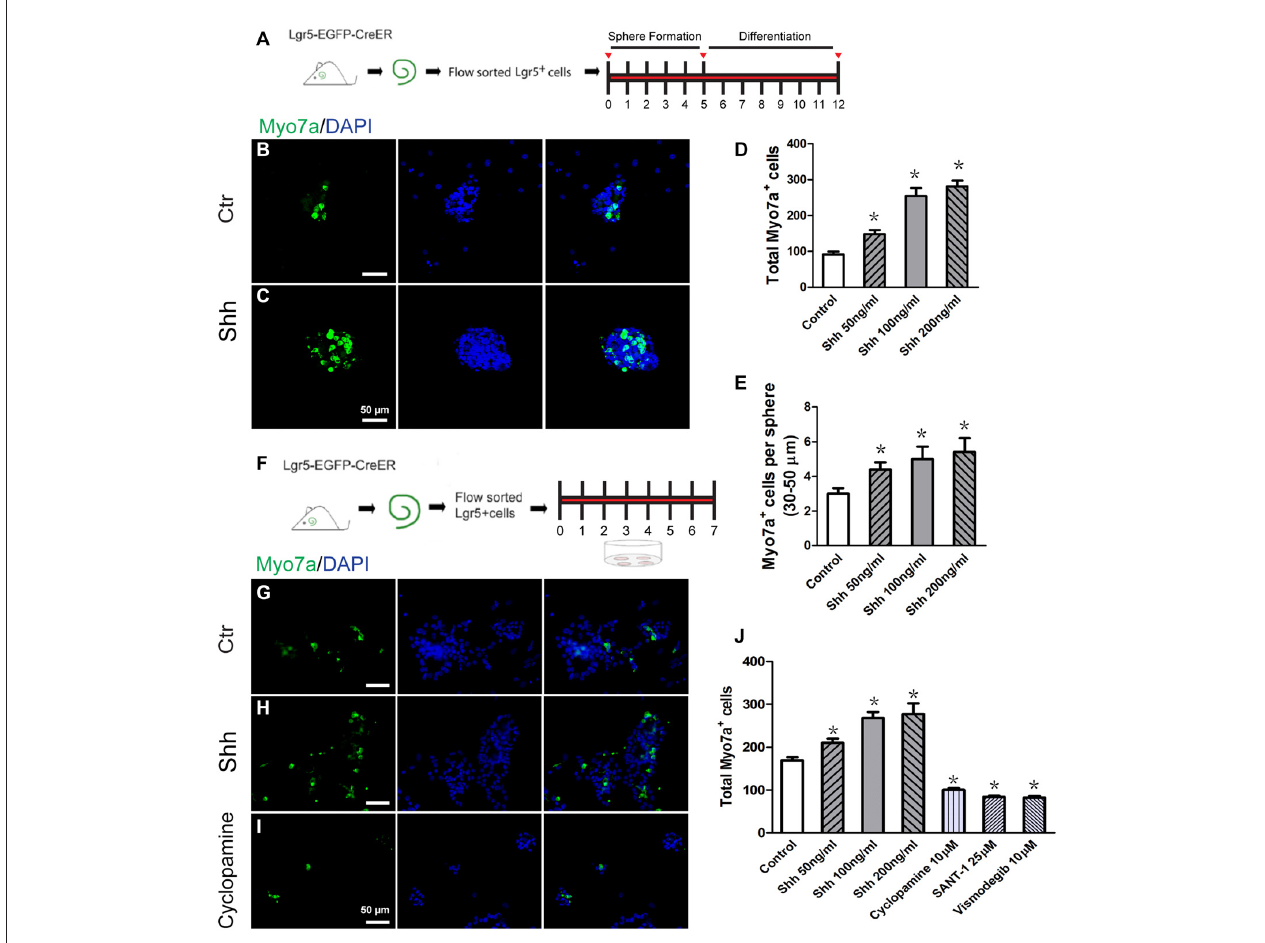
FIGURE 2 | Hedgehog signaling enhanced the hair cell (HC) differentiation of inner ear progenitor cells in vitro . (A) Diagram of the differentiation assay in Lgr5+ cell spheres. After allowing spheres to form for 5 days, the spheres were collected and cultured in medium that is suitable for cell differentiation for a further 7 days. The cells were stained with antibodies against Myo7a and with DAPI after 12 days of culture. (B) Spheres formed by the Lgr5+ progenitor cells generated some Myo7a+ cells when cultured in differentiation medium for 7 days in the control group. (C) The Shh protein-treated spheres generated more Myo7a+ cells. (D) The total number of Myo7a+ cells per well. (E) The average number of Myo7a+ cells per sphere (30–50 µ m) in the control and Shh protein-treated groups. (F) Diagram of the direct differentiation assay. A total of 2000 sorted Lgr5-EGFP+ progenitor cells were cultured on 4-well plates at a density of 20 cells/ µ l for 7 days in serum-free medium. (G–I) Representative images of Myo7a immunofluorescence after 7 days of culture in the control, Shh protein-treated, and cylcopamine-treated groups. (J) The number of Myo7a+ cells increased significantly in the Shh protein-treated group and decreased significantly in the Hedgehog antagonist (cyclopamine, SANT-1, or vismodegib) group when compared with the control group. Data are presented as means ± SE. N = 5, ∗ p < 0.05 vs. the control group. Scale bars (B–C,G–I) are 50 µ